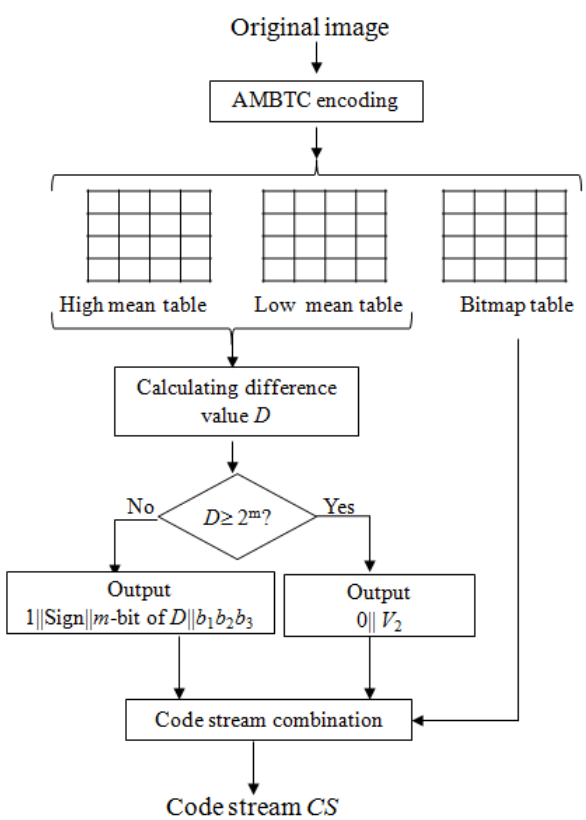
Figure 4. Flow chart of the proposed embedding